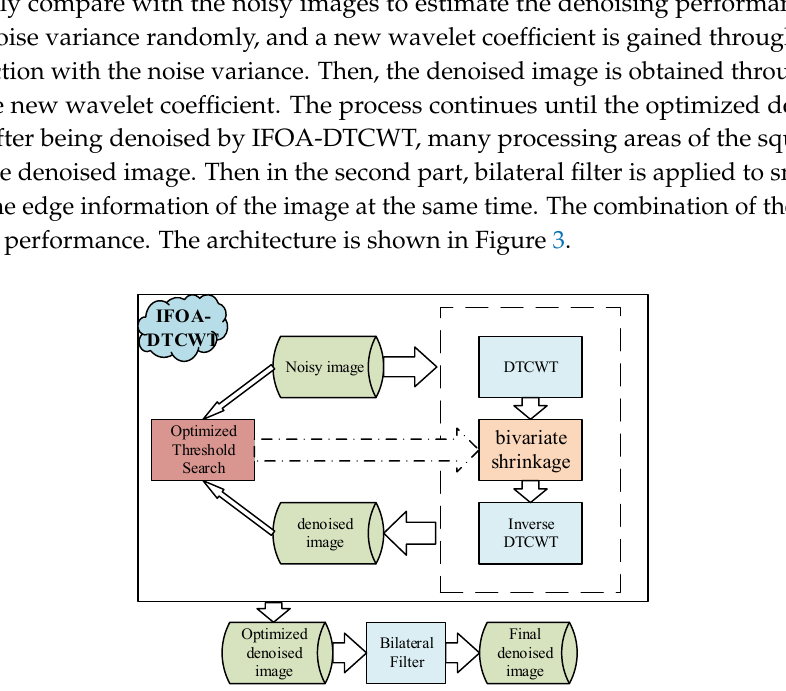
Figure 3. Architecture of enhanced dual ‐ tree complex wavelet optimized by fruit fly algorithm and bilateral filter (IFOA ‐ DTCWT ‐ BF). bilateral filter